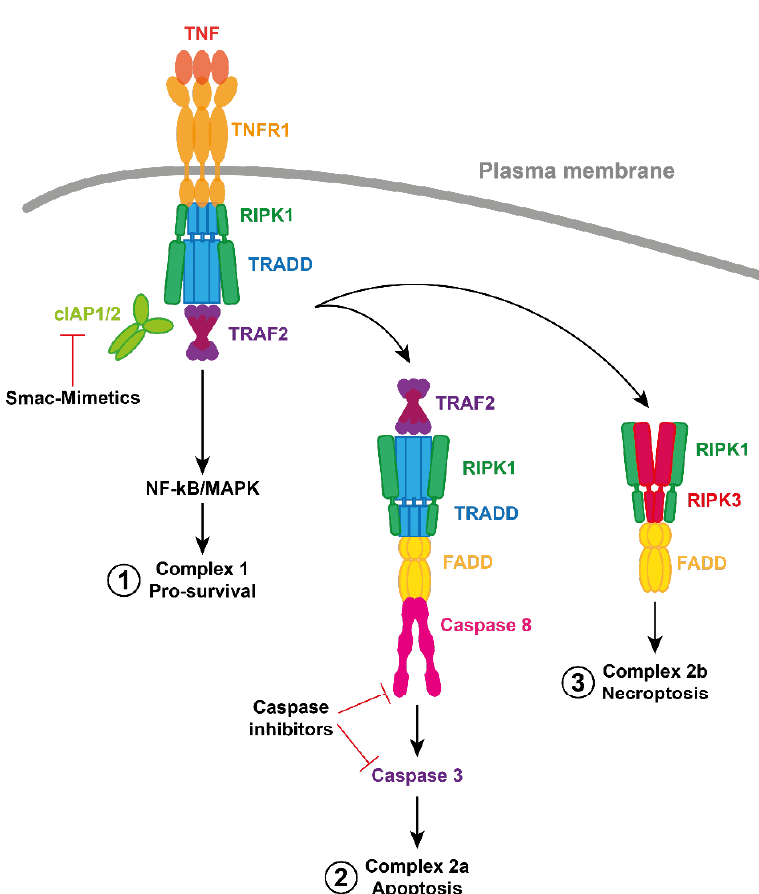
Figure 2. Simplified schematic of TNFR1 Signaling. Formation of complex 1 can lead to activation of canonical NF- κ B and MAPK pro-survival